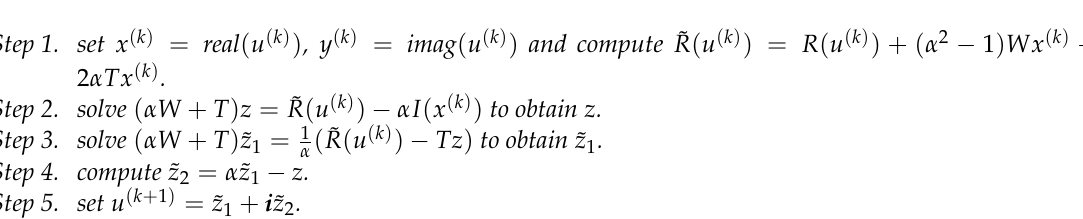
u ( 0 ) ∈ C n . For k = 0, 1, 2, · · · , until { u ( k ) } converges, compute the next iterate { u ( k + 1 ) } according to the following